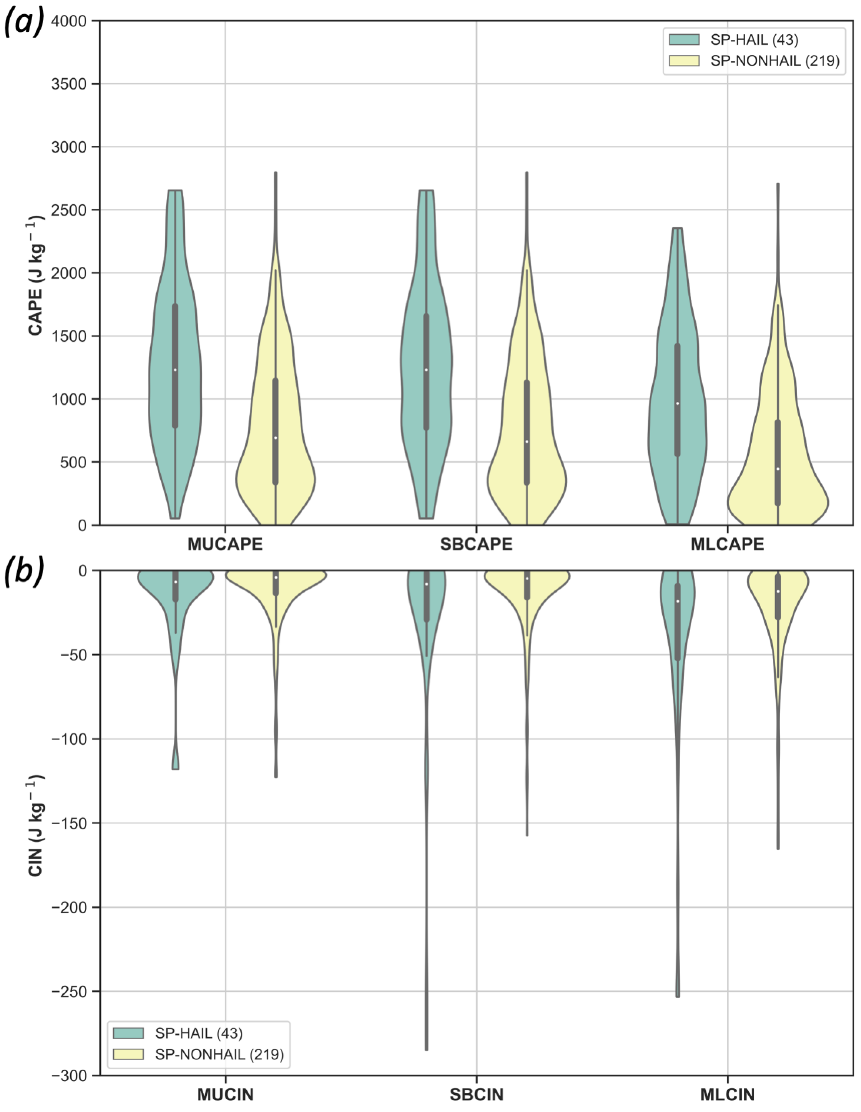
Figure 8. As in Fig. 7, but for (a) MUCAPE, SBCAPE and MLCAPE. (b) MUCIN, SBCIN and MLCIN.